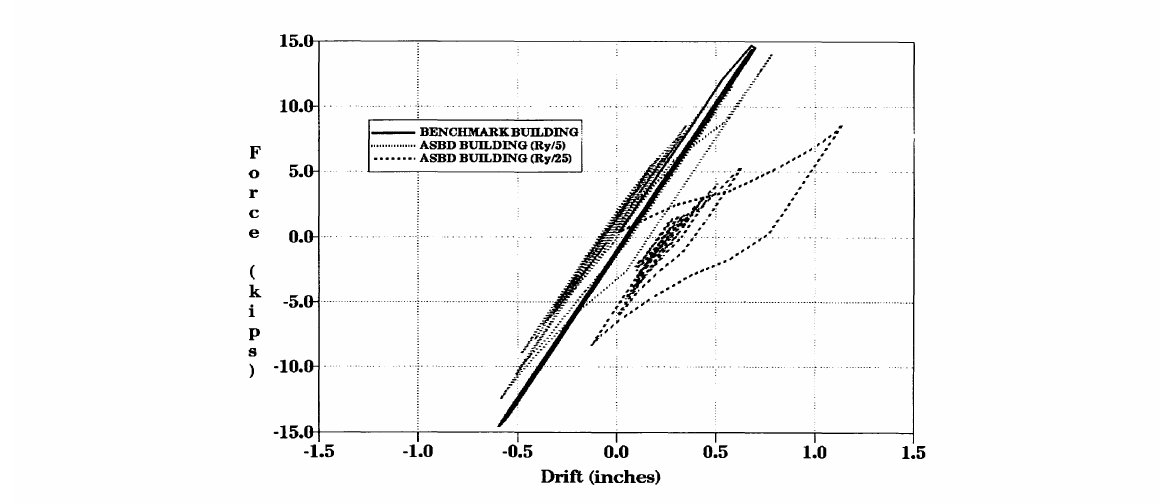
FIGURE 6 Comparison of building brace force under impulsive ground